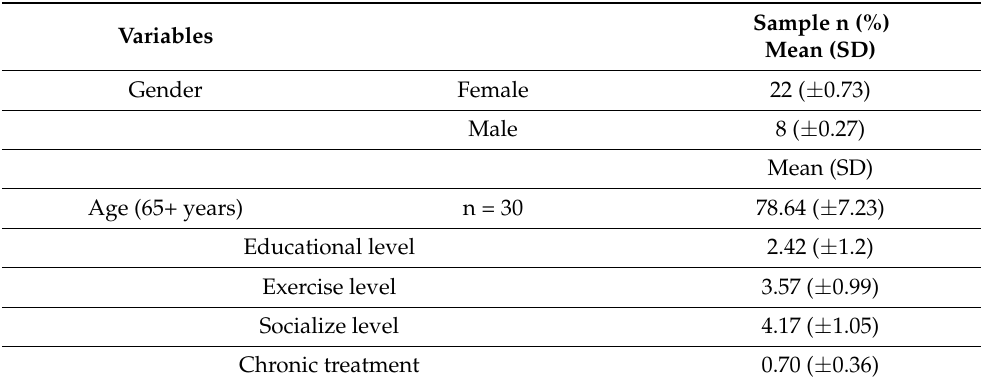
Table 1. General description of the population sample